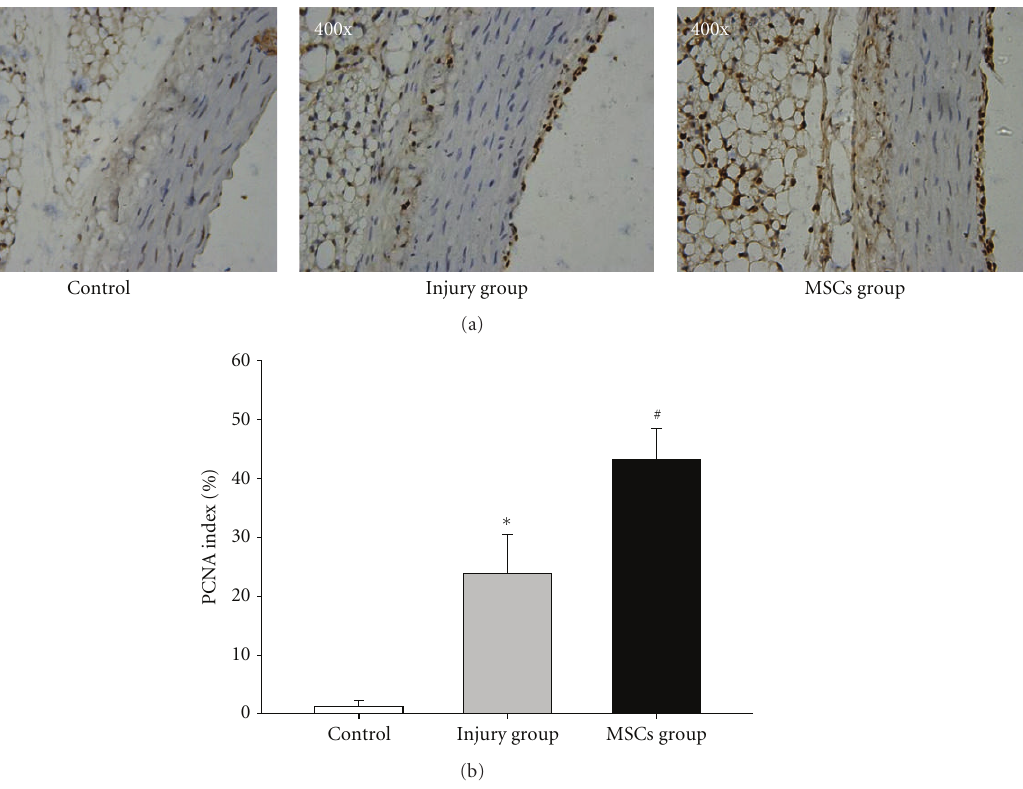
Figure 3: E ff ect of BM-MSCs on neointimal formation after balloon angioplasty. (a) The PCNA expression was evaluated immunohisto- chemically to investigate proliferative activity in vascular tissue. PCNA-stained nuclei were detected in the neointimal and medial layers of vascular wall at 6 weeks after vascular denudation. (b) PCNA index was significantly increased after BM-MSCs transplantation compared with injury group. The data were expressed as means ± SEM. n = 8 per group. ∗ P < 0 . 05 versus control, # P < 0 . 05 versus injury